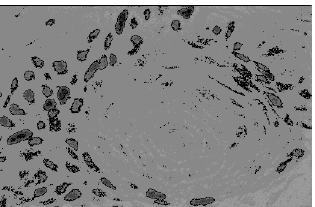
Fig. 2. PCNA expression in acanthomatous pattern of ameloblastoma. Positive nuclei for PC10 are not observed in the meta- plastic squamous cells within the islands of follicular pattern. Some nuclei of peripheral cells in the follicular pattern which surrounds the area of acanthomatous pattern are positive for PC10. ABC method with methyl green counterstain, × 200.